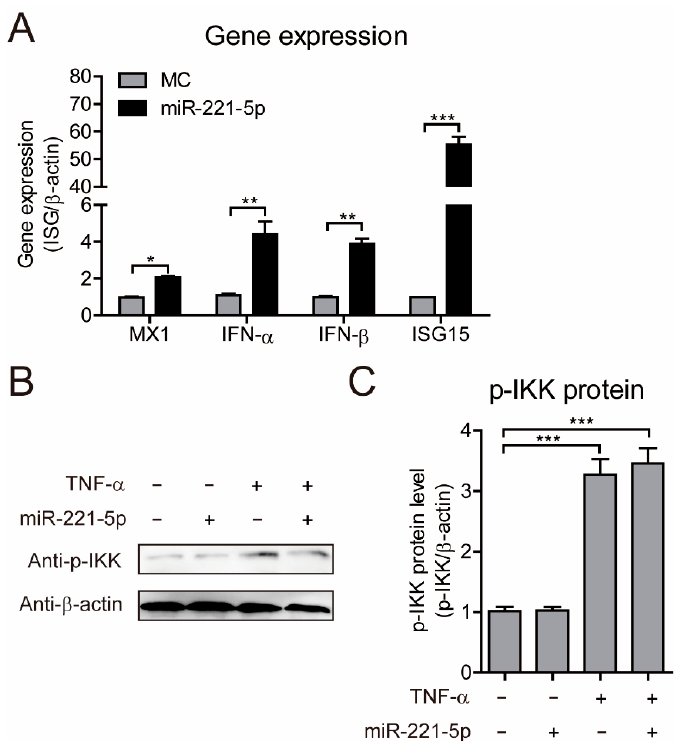
Figure 5. miR-221-5p increases type I IFN and ISG expression during PEDV infection. ( A ) Real-time qRT-PCR analysis of IFN- α , IFN- β , MX1 , and ISG15 mRNA levels (normalized to β -actin expression) in MARC-145 cells transfected with 50 nM miR-221-5p mimics or MC for 24 h, followed by infection with CH/HBTS/2017 at an MOI of 0.1 for 24 h. Data represent the mean ± SD of three independent experiments, and measured in technical duplicate. ( B ) Immunoblot analysis of phosphorylated IKK (p-IKK) levels in MARC-145 cells transfected with 50 nM miR-221-5p mimics or MC for 24 h, followed by infection with CH/HBTS/2017 strain at an MOI of 0.1 for 24 h, and stimulation with 15 ng/mL for 12 h. ( C ) The intensity represents p-IKK levels normalized against that for β -actin across three independent experiments. Comparisons between groups were determined by Student’s t test. * p < 0.05; ** p < 0.01; *** p < 0.001. “+” treated; ” − “ untreated.